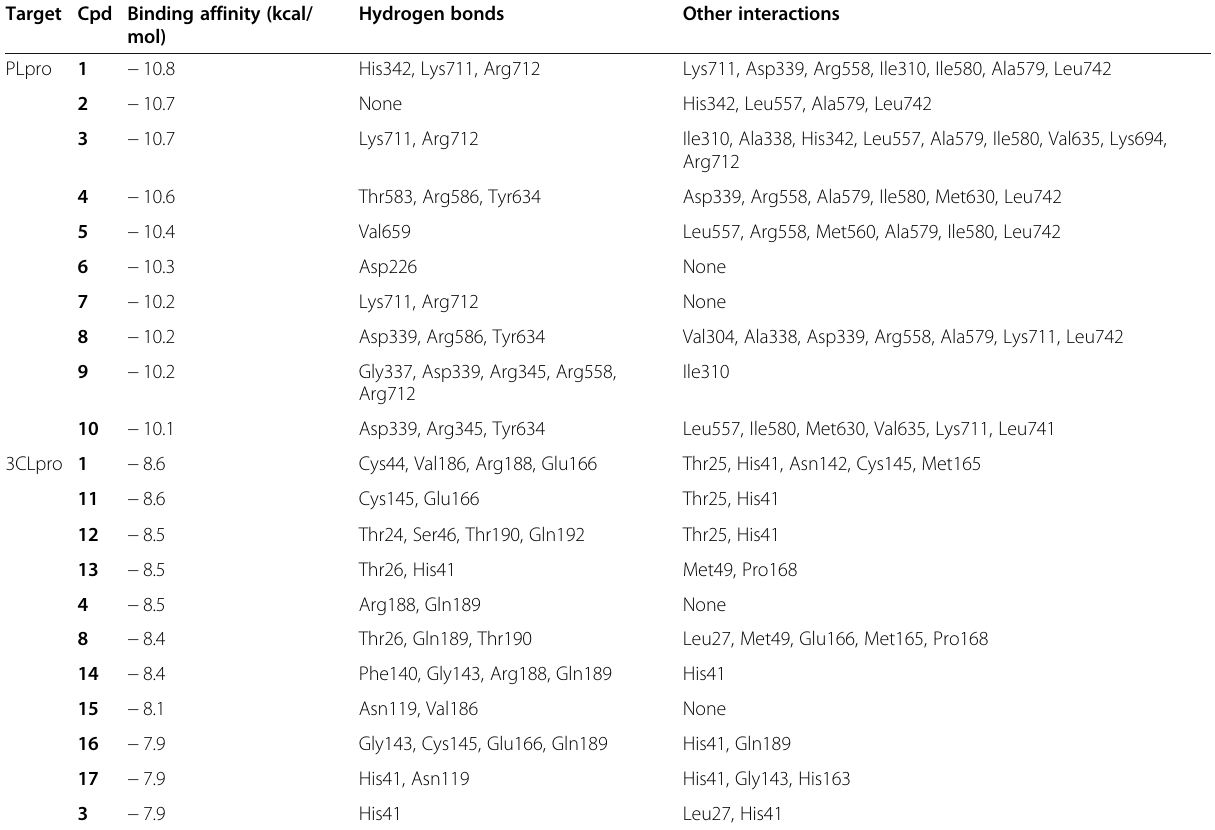
Table 1 Binding affinities and interactions of top ten ligands against the cysteine proteases Target Cpd Binding affinity (kcal/ Hydrogen mol)